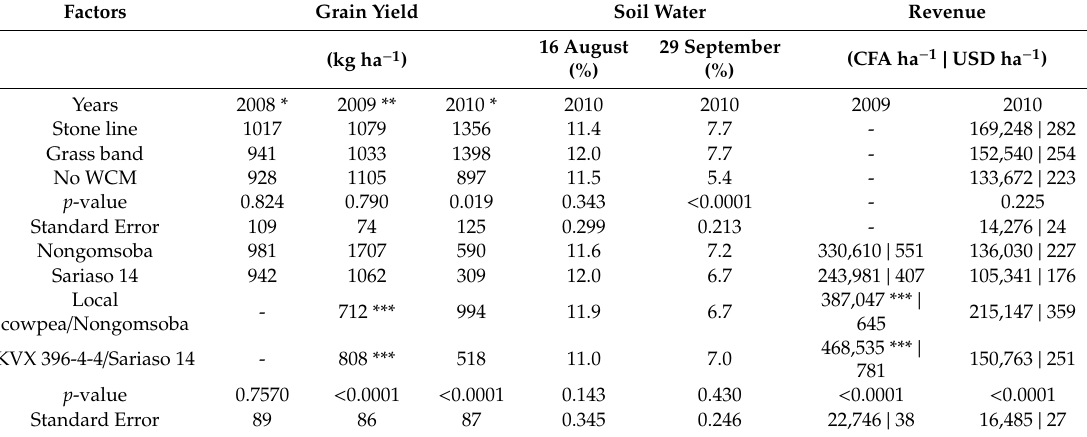
Table 2. Analyses of variance results for mean soil water, grains yield, and